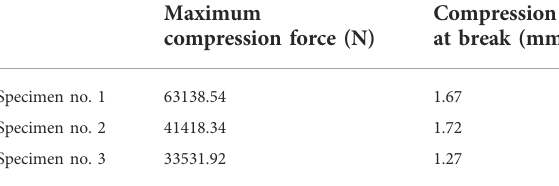
TABLE 3 Compression test results of the three test specimens.